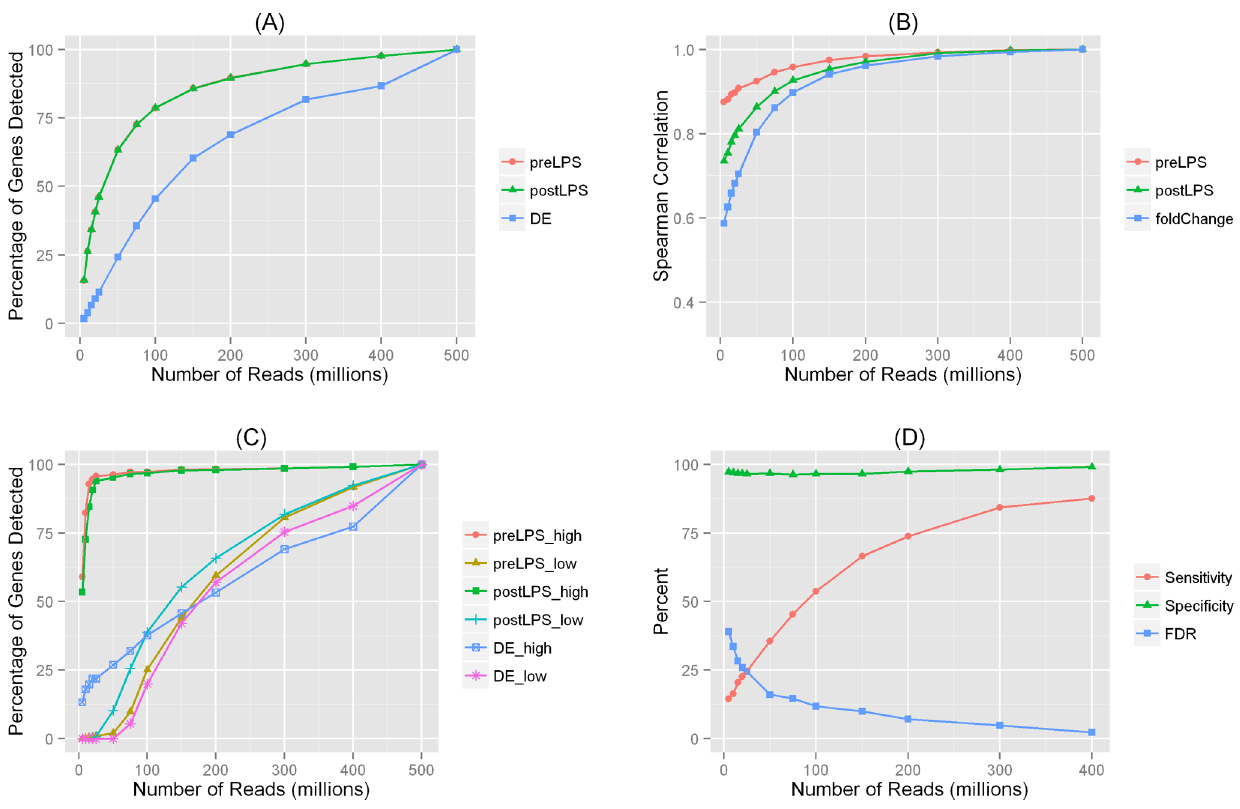
Figure 1. Analysis results for differentially expressed (DE) genes in adipose. ( A ) Percentage of detected expressed genes and differentially expressed (DE) genes for datasets with various sequencing depths. PreLPS: detection rate for expressed genes in the pre-LPS sample; post-PLS: detection rate for expressed genes in the post-LPS sample; DE: detection rate for DE genes. The curves for pre-LPS and post-LPS samples overlap, although the numbers of detected genes were different (Table S1). ( B ) Spearman correlation between FPKM values in datasets with various sequencing depths and FPKM values in the 500 M-read datasets. PreLPS: correlation of FPKM values in the pre-LPS sample; postLPS: correlation of FPKM values in the post-LPS sample; fold-change: correlation of the fold change of FPKM values. ( C ) Percentage of detected DE genes according to gene expression levels. PreLPS_high: detection rate for gene expression in highly expressed genes in the pre- LPS sample; preLPS_low: detection rate for gene expression in lowly expressed genes in the pre-LPS sample; postLPS_high: detection rate for gene expression in highly expressed genes in the post-LPS sample; postLPS_low: detection rate for gene expression in lowly expressed genes in the post- LPS sample; DE_high: detection rate for DE genes in highly expressed genes; DE_low: detection rate for DE genes in lowly expressed genes. ( D ) Performance of DE genes detected in datasets with various sequencing depths.